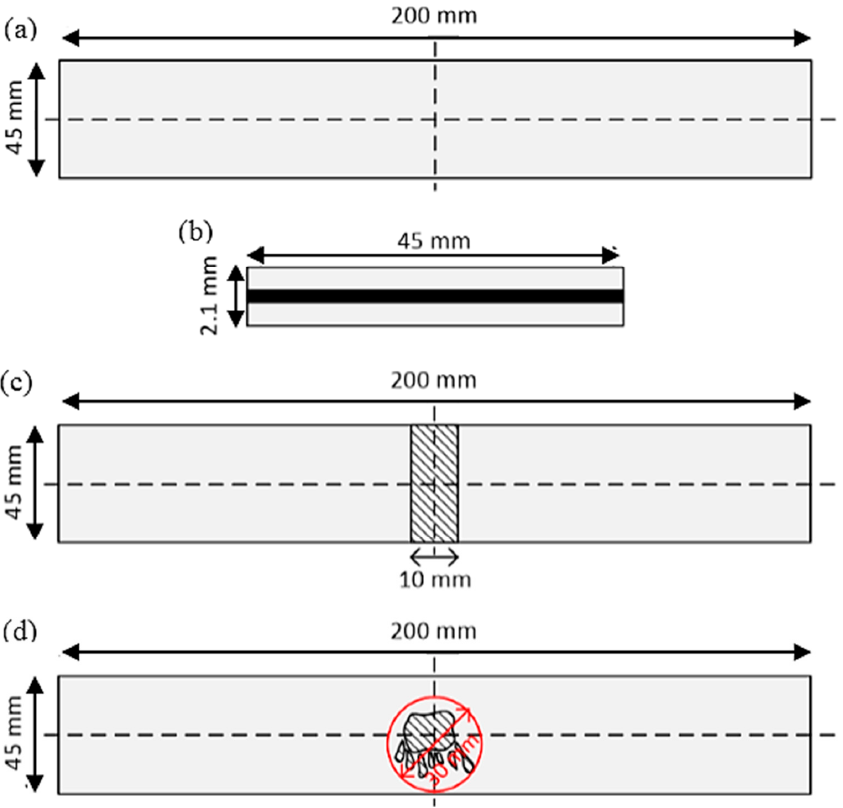
Figure 4. Specimen geometrical information: ( a ) top view of the adhesive bond aluminum plate; ( b ) cross-sectional view of the target specimen; ( c ) debonding area of adhesive bonded aluminum plate 1; and ( d ) debonding area of adhesive bonded aluminum plate 2.